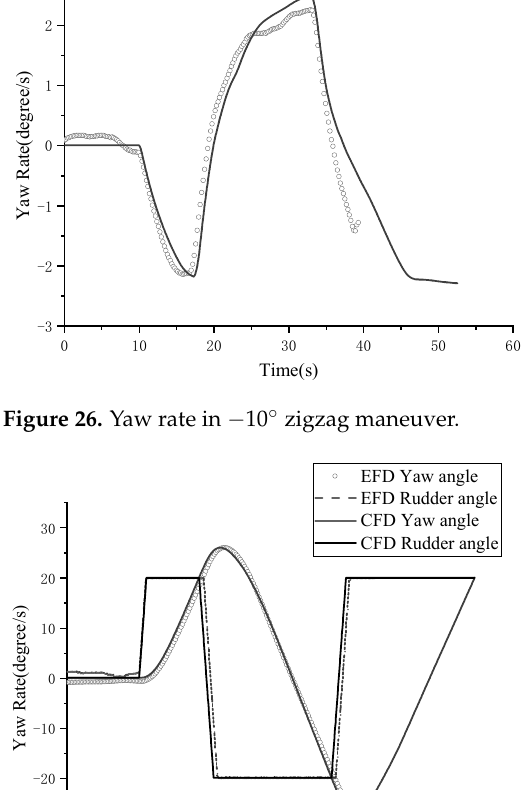
Figure 27. Heading and rudder angle in 20° zigzag maneuver.